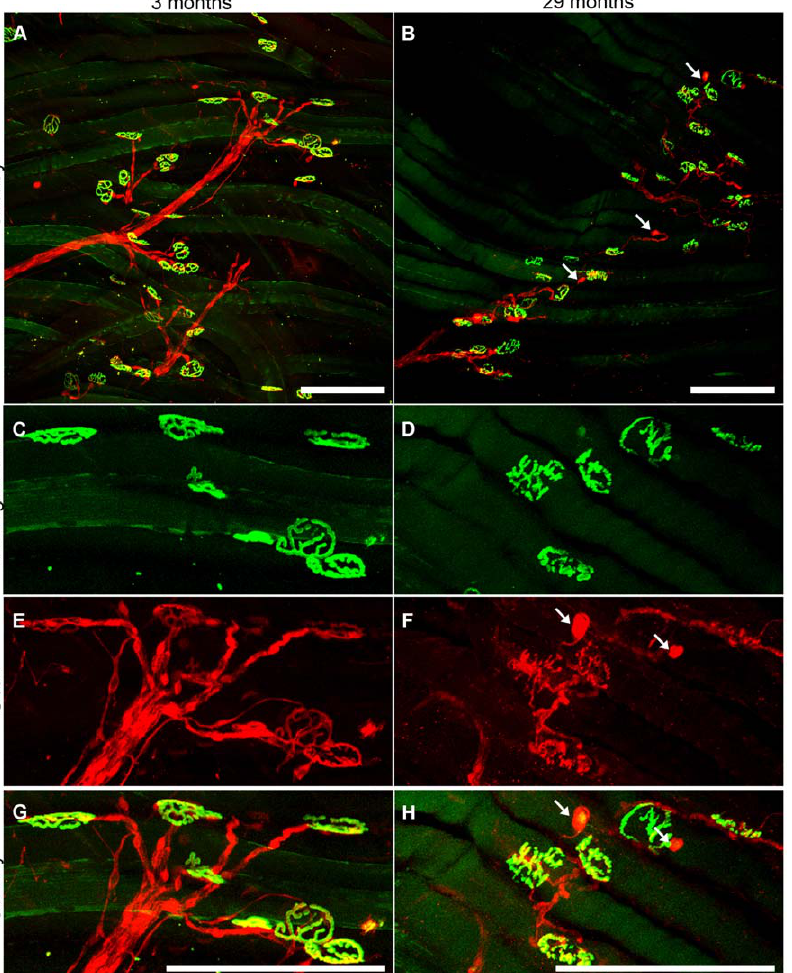
Figure 4. Age-related changes in the Schwann cells (SCs) at the NMJs. Low (A,B) and high (C,D,E,F,G,H) power views. Confocal images of NMJs and SCs in the EDLs of 3 (A,C,E,G) and 29 (B,D,F,H) month old mice. High power views show that SCs of young mice are structured and completely overlay with the muscle endplates (C,E,G). SCs of old mice are disorganised, partially cover muscle endplates and have swollen endings (white arrows) (D,F,H). Scale bars are 150 m m.